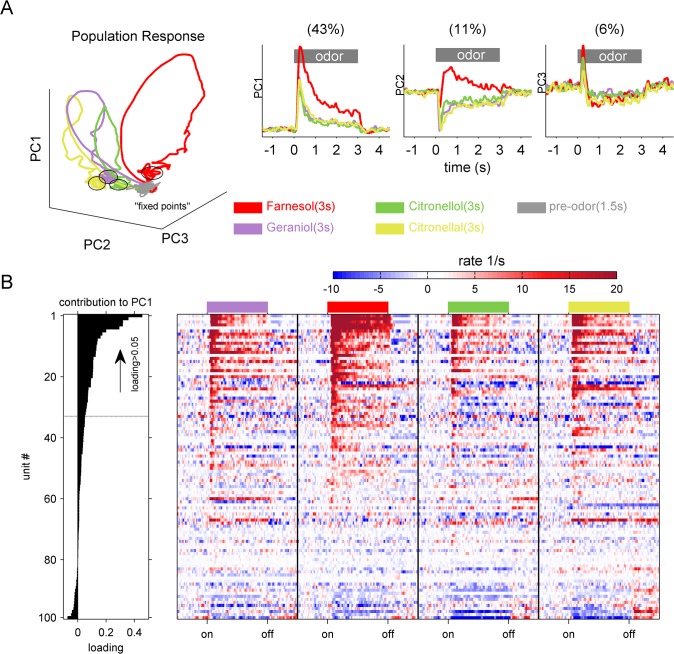
Principal component analysis revealed a prominent combinatorial code extraction of farnesol.(A) Trajectories of the first three principal components (PC1-3) indicate a clear odor separation by the population activity of the 100 AL-units. PC1, PC2 and PC3 explained 43%, 11% and 6% of the variation, respectively. The spontaneous activity before odor onset is shown in grey (Pre-stim). The three second of stimulation are plotted in an odor dependent color code (cp. caption). Note that the population activity for all odors settled in a ‘fixed point’ at around one second after odor onset (cp. PC1-3 time resolved; right three panels), which is separated from the spontaneous activity. The population activity in response to farnesol shows the most separated trajectory, which is also illustrated separately for each of the first three PCs on the right. (B) The factor loadings (left panel) were used to rank the recorded single units with respect to their contribution to the variation in PC1 starting with the most contributing units at the top. The color coded mean firing rate of the single units illustrates that PC1 contrasted units being excited (positive loadings) by the odor stimuli from a few units being inhibited (negative loadings). Furthermore, the colored matrix suggests a spatial code, e.g. unit 5, 14 and 20 were responding only to farnesol and none of the other stimuli. To further analyze odor induced activity, we set a threshold and extracted all units showing factor loadings >0.05.